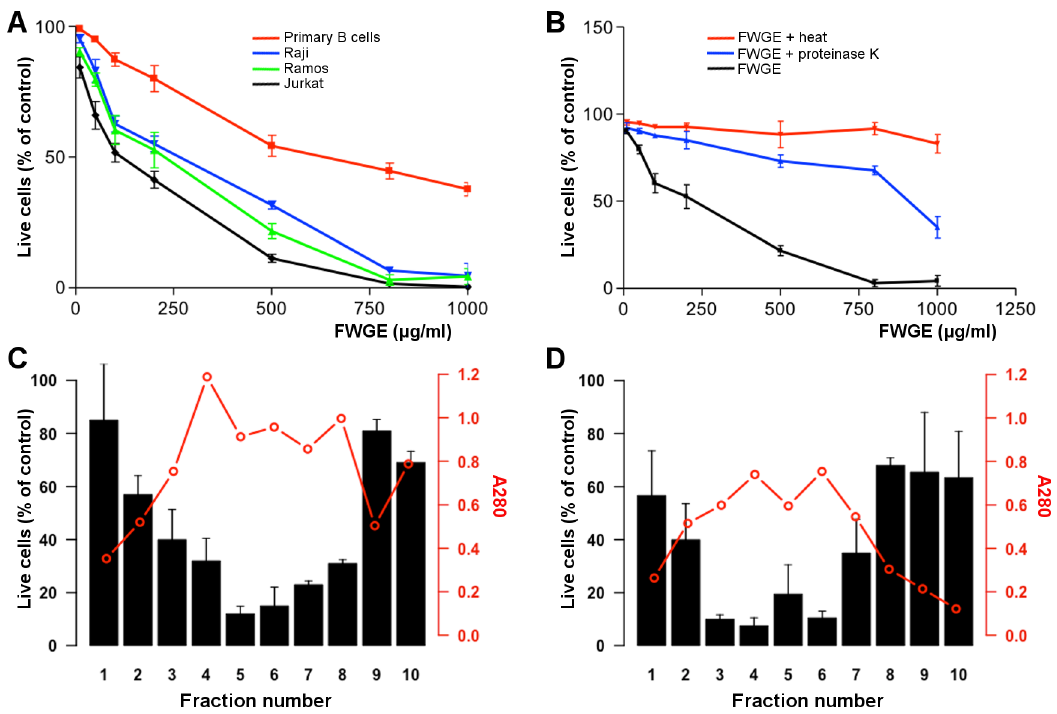
Fig 1. In vitro lymphomacidal activity of FWGE and FWGP. (A) Raji, Ramos, Jurkat and normal primary humanB cells were incubatedwith increasingconcentrations of fermentedwheat germ extract (FWGE) for 72 hours. Viability was measuredby MTS assay. Data points indicate the mean of 3 biologicalreplicates, each in triplicate; error bars represent standarddeviation. (B) FWGE was heated or treated with proteinaseK and cytotoxicity was assessedas in (A). Cytotoxic activity againstRaji cells (as % of trypan-blue negative cells relative to untreated controls) and protein chromatographic profile (as A280) of the ethanol-insolubleextract from FWGE separated on SephadexG50 ( C ) and SuperdexG200 ( D ).